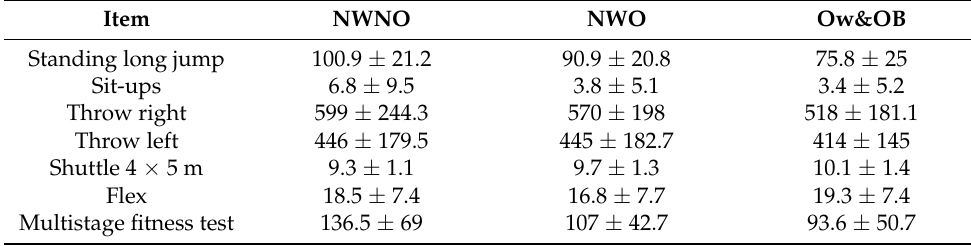
Table A1. Raw values regardless sex of